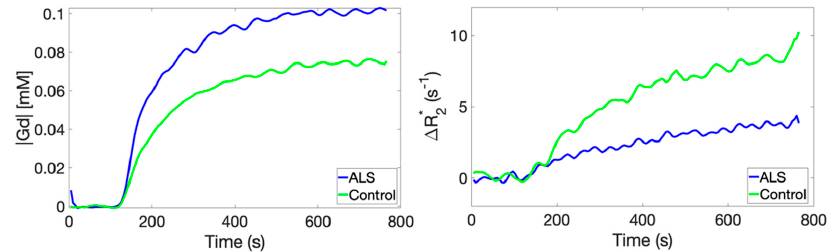
Figure 1. A comparison of time-dependent CA concentration curves ( left ) and transverse relaxation rate changes ( right ) obtained in the tibialis anterior muscle compartment of an ALS patient and a healthy control.